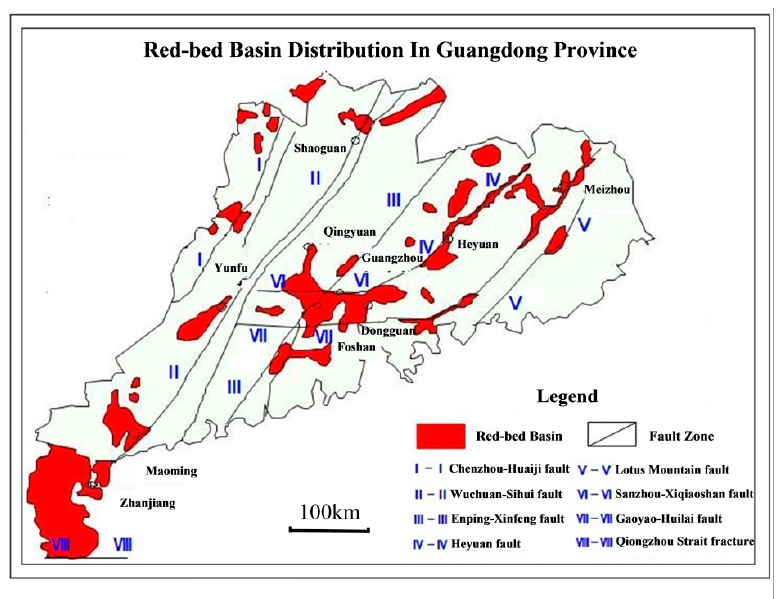
Figure 2. Distribution of red-bed basins and principal fault zones in Guangdong Province [1].